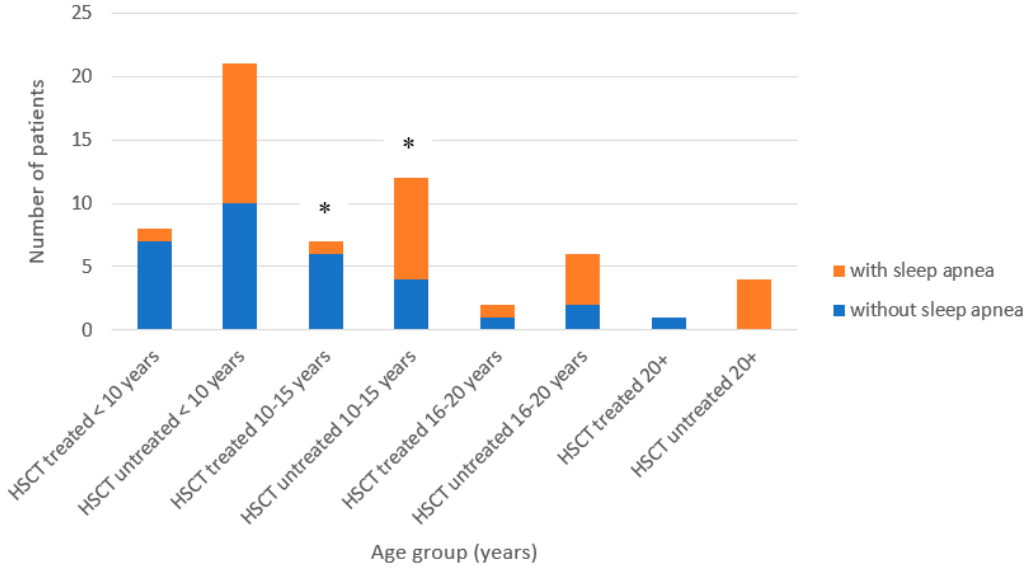
Figure 3. Sleep apnea in severe phenotype MPS-II patients. * = p < 0.05.